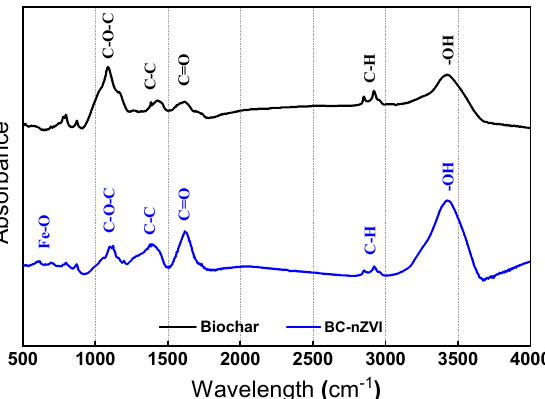
Figure 4. FTIR spectra of biochar and BC-nZVI (nZVI modified form of biochar) represented the functional groups on their surfaces.